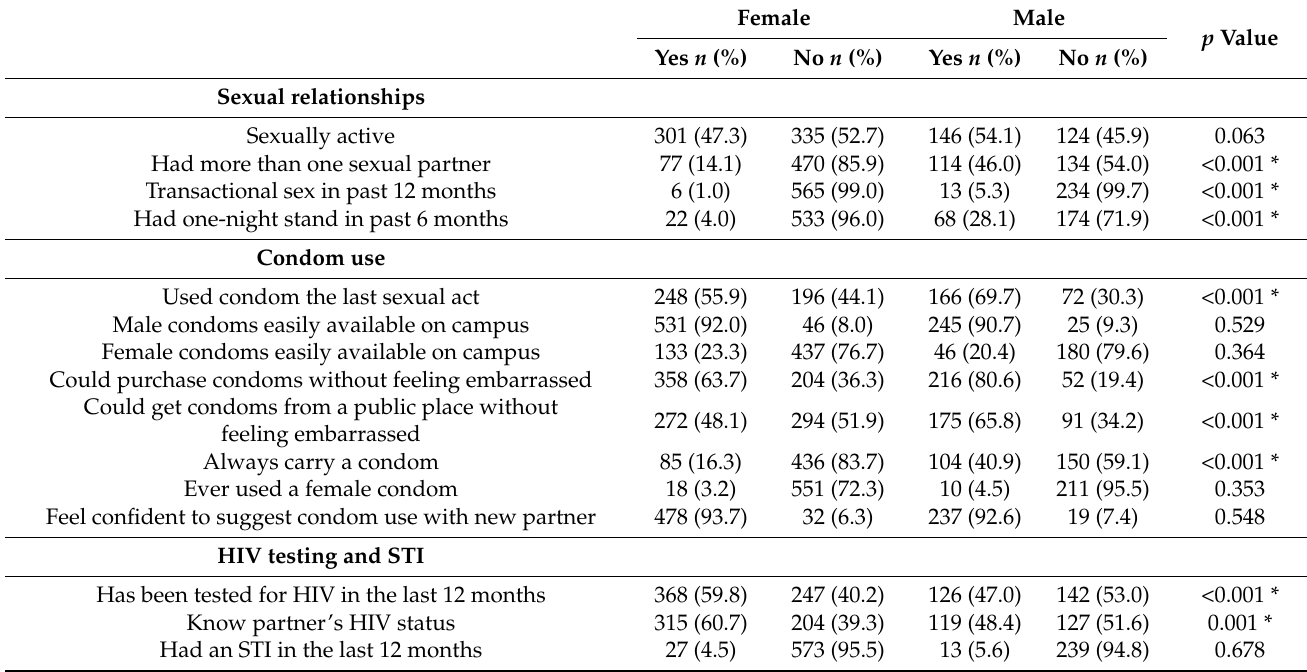
Table 2. Risky sexual behavioural characteristics and condom use in university students by